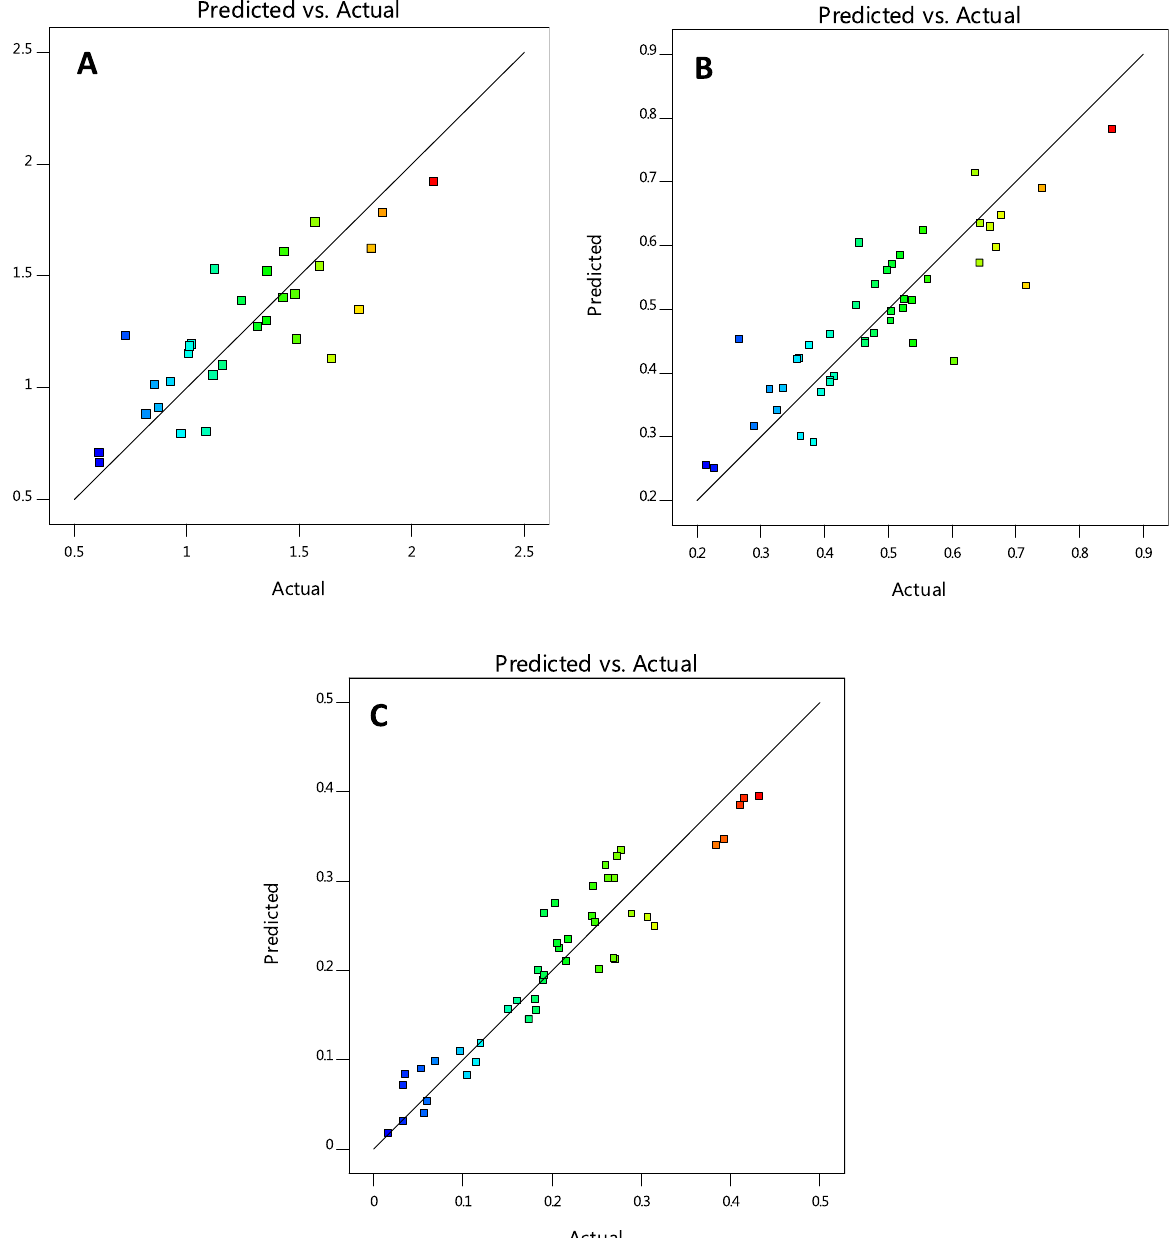
Figure 11. Model graphs of predicted versus actual design values for ( A ) wear rate, ( B ) specific wear rate, & ( C ) wear It could be observed that the data points are split evenly by the 45-degree line, indicating that the design models are sufficient to predict the responses 16,23 . For response surface designs, the primary model graphs are the 3D and contour plots. The contour plot is a two-dimensional (2D) representation of a response variable plotted against combinations of numeric factors. It can show the relationship between the responses and the numeric factors 24 . The 3D Surface plot is a projection of the contour plot giving shape in addition to the color and con- tour. Figure 12A–C are interactive 3D surface plots, showing the degree of interaction among the factors and the response variables at the specified categoric factor level (B4). An interaction occurs when the response is different depending on the settings of the two numeric factors (Load and speed) 25 . They will appear with two non-parallel lines, indicating that the effect of one factor depends on the level of the other. The perturbation plot of Fig. 13A–C is employed to compare the effects of all the factors at a particular point in the design space. The response is plotted by changing only one factor over its range while holding all the other factors constant. By default, Design-Expert sets the reference point at the midpoint (coded 0) of all the factors. This can be changed to be any point (perhaps the optimal run conditions) by using the Factors Tool. A steep slope or curvature in a factor shows that the response is sensitive to that factor. A relatively flat line shows insensitivity to change in that